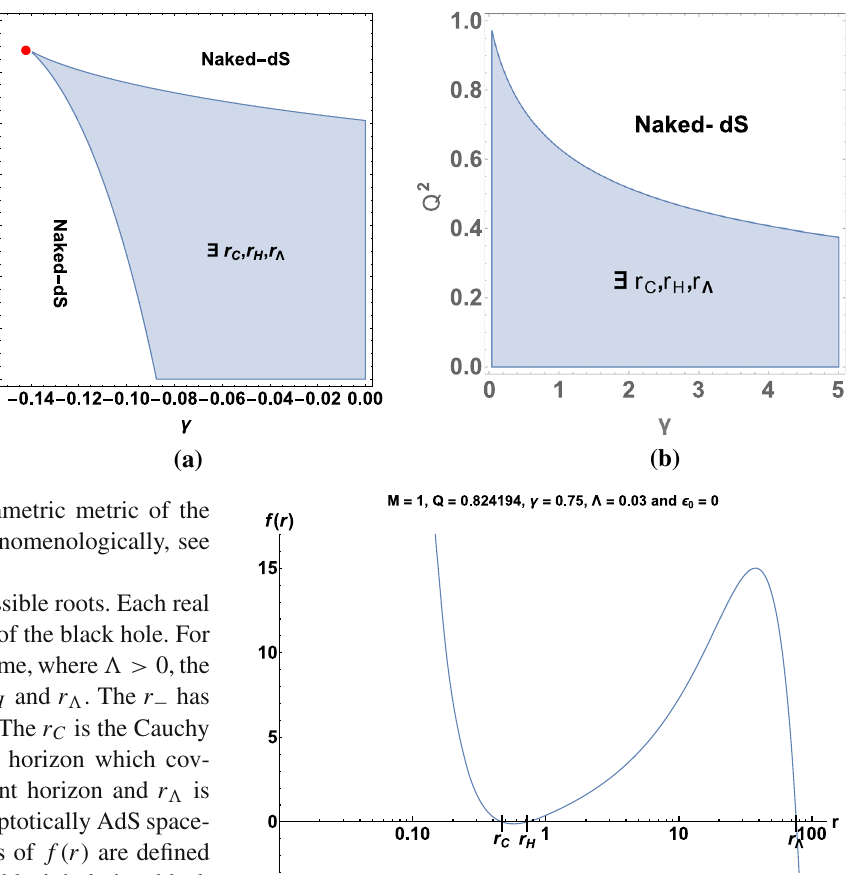
Fig. 2 Behaviour of f ( r ) in near-extremal cases with positive cos- mological constant for r C ∼ r H . This scenario has large universe in r H < r < r (cid:6) region